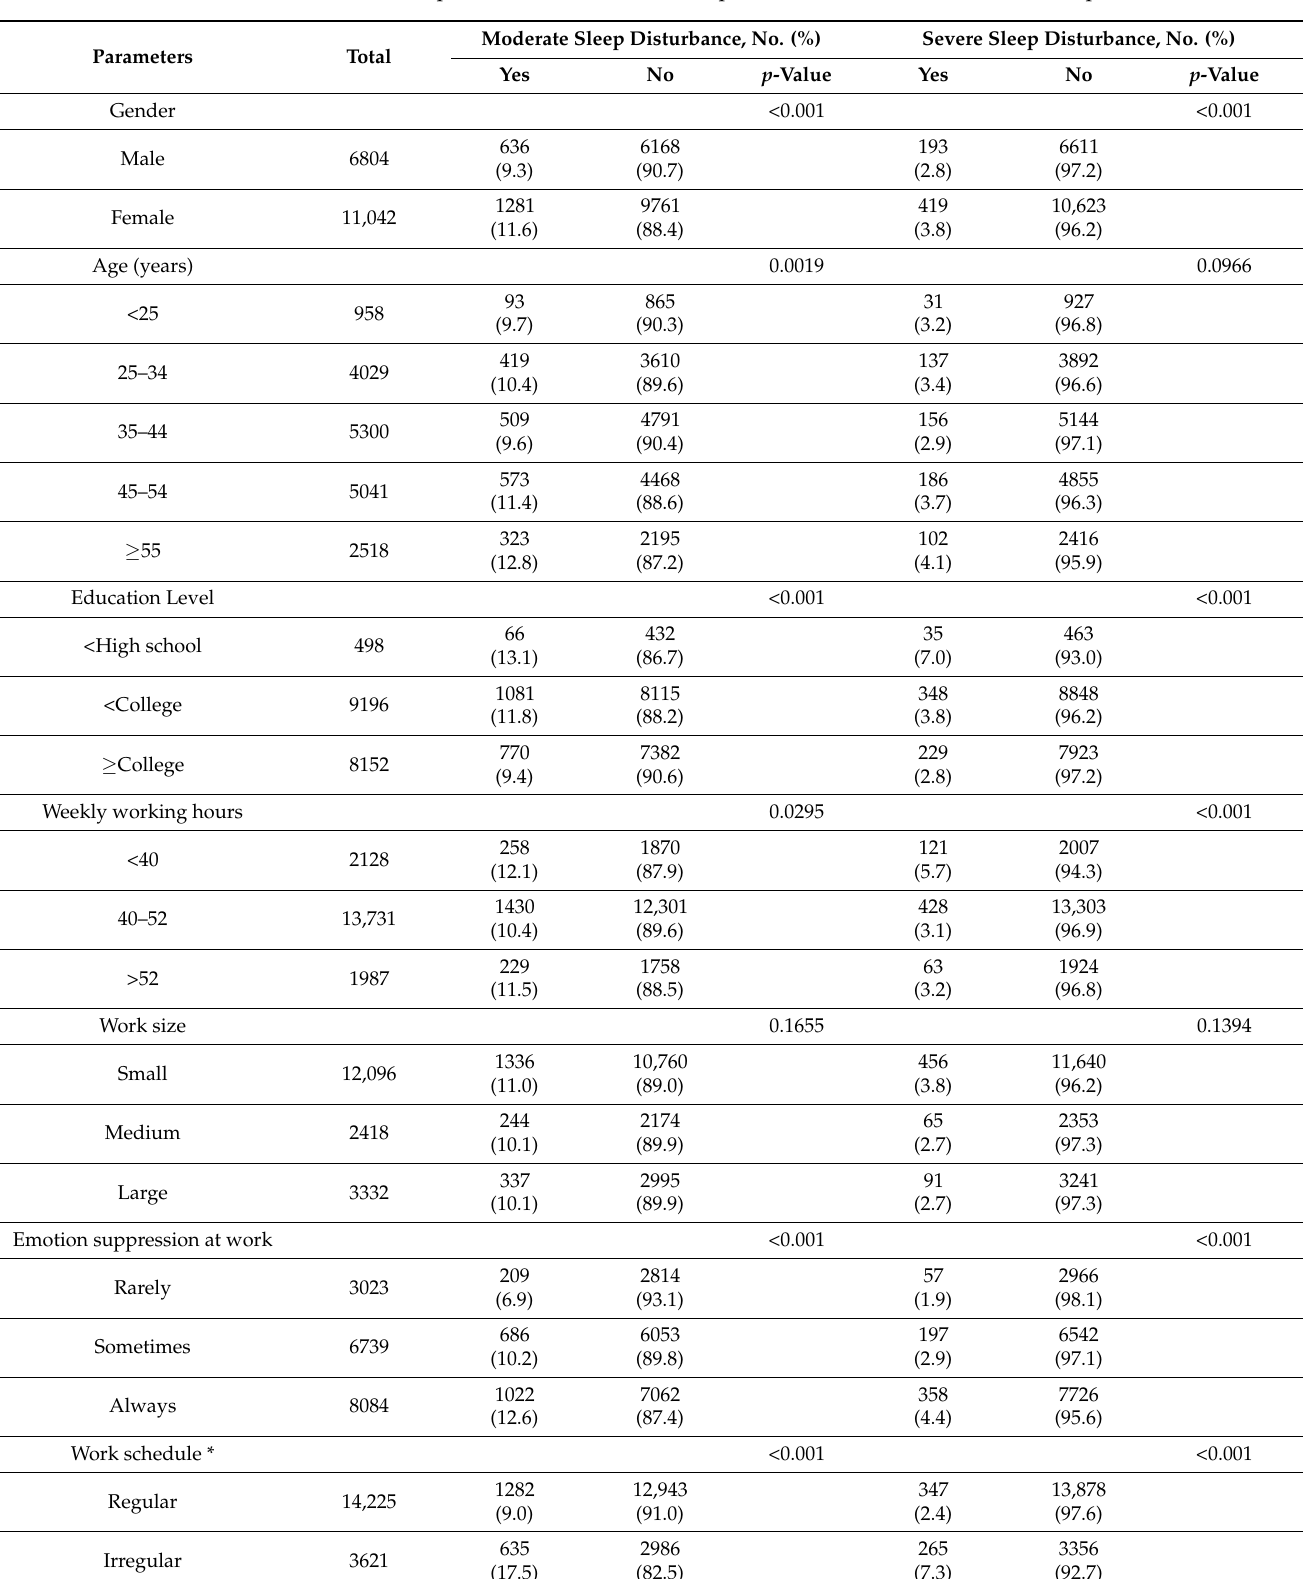
Table 1. Basic characteristics of the study population based on sleep disturbances. Chi-squared tests were used to compare socioeconomic characteristics and occupational status based on the presence of moderate and severe sleep